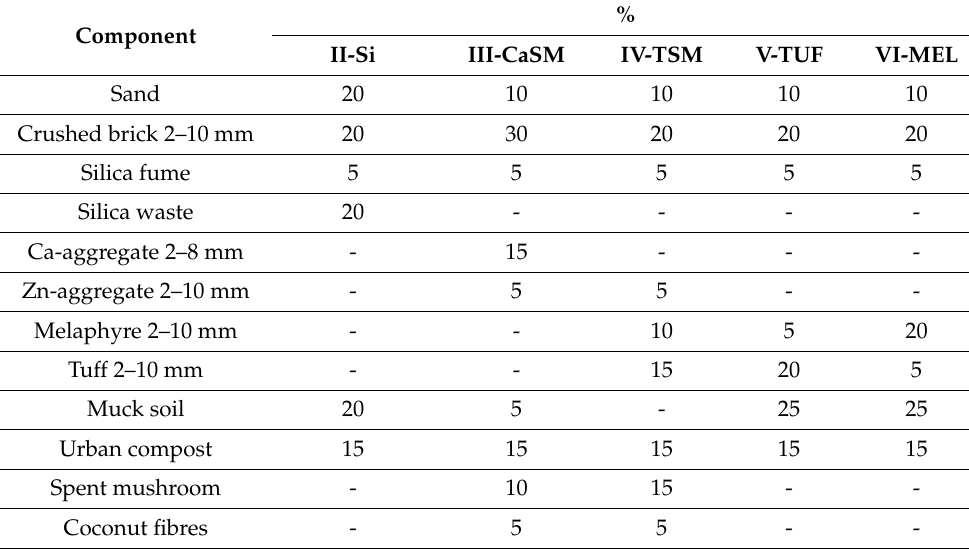
Table 1. Composition of prepared green roof